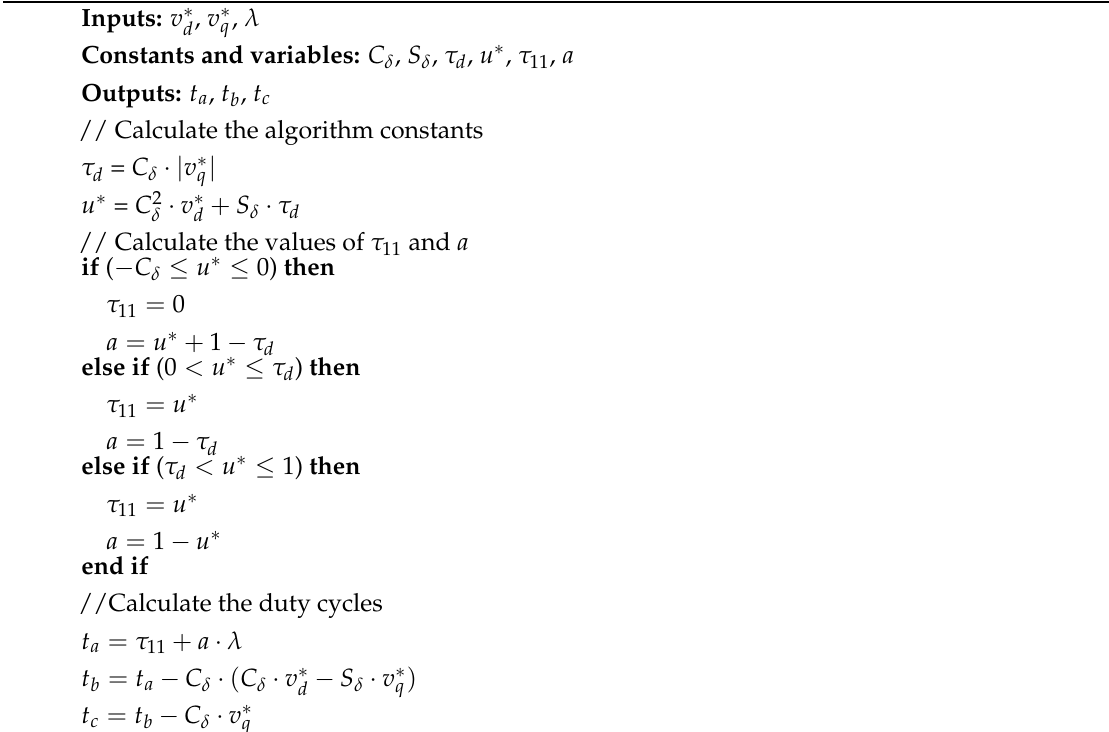
Algorithm A1: Generalised PWM for three-phase